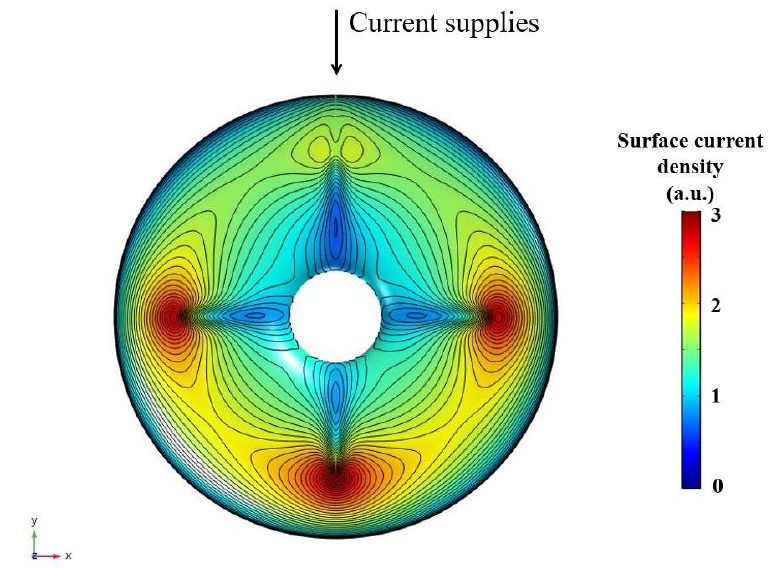
Figure 3. Calculated surface current density distribution at the free surface of the melt, as determined from the electromagnetic (EM) model.